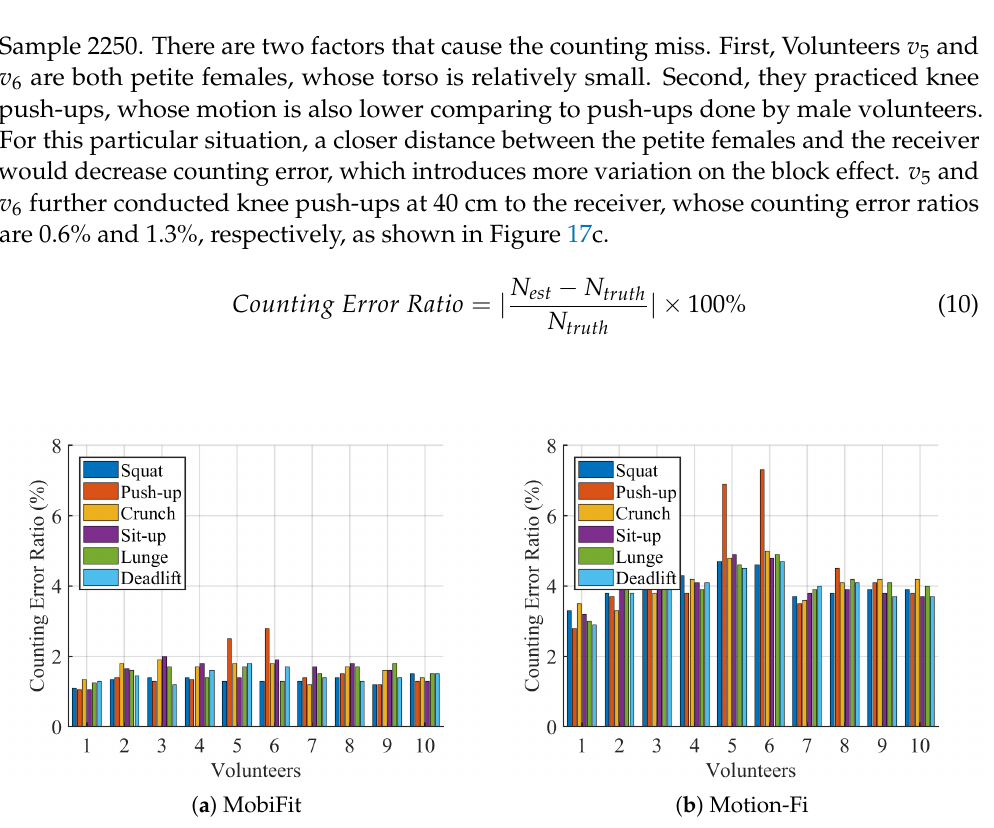
Figure 16. Counting error ratio comparison.